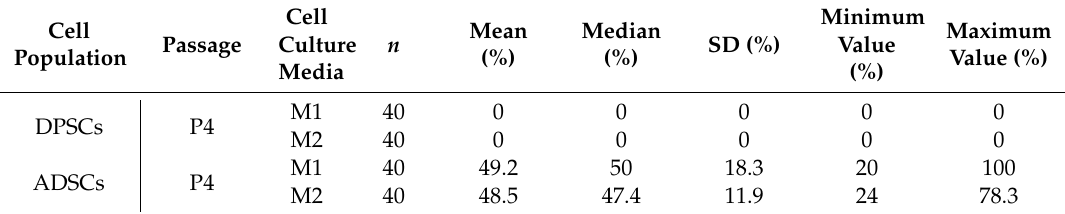
Table 1. Descriptive percentage values of Oil Red O